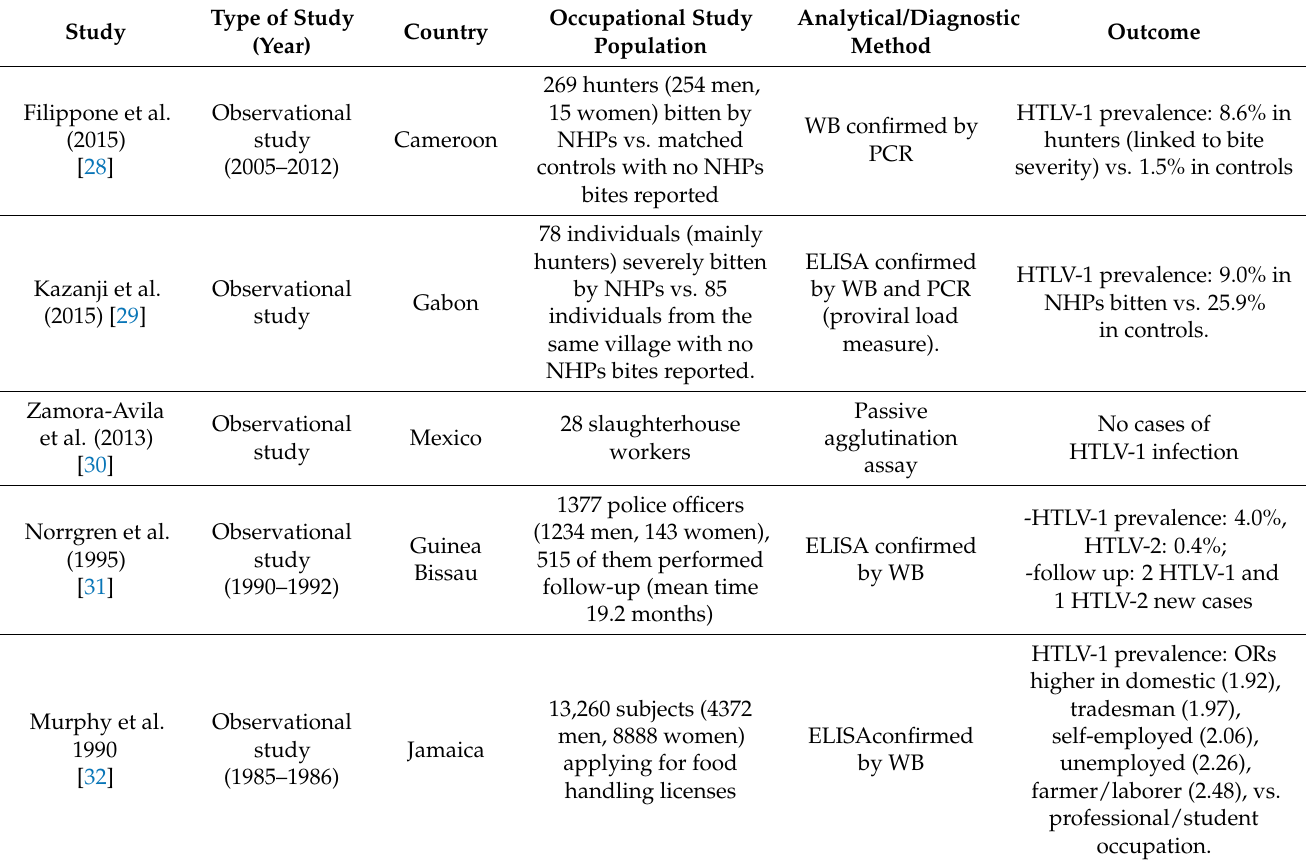
Table 2. Studies on work-related HTLV-1/2 infection in non-health care